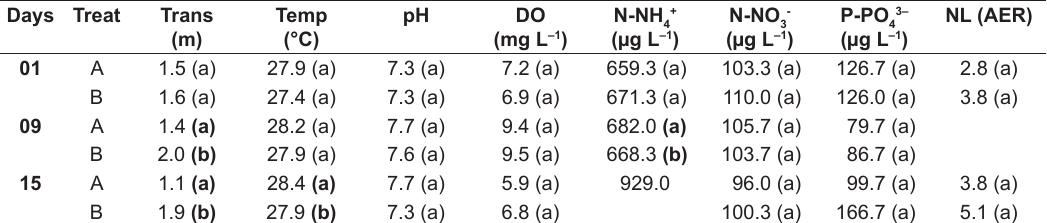
Table 1. Mean values of the physical and chemical variables in the mesocosms with fish (Treatment A) and fish free (Treatment B).